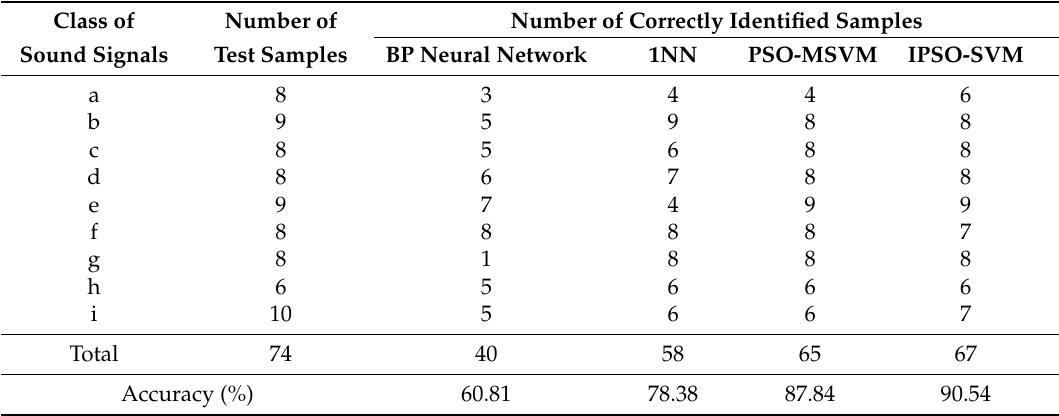
Table 2. The identification results using different classifiers.